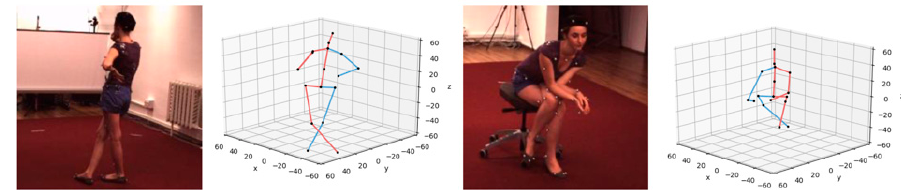
Figure 5. Failure to evaluate results of 3D human poses.